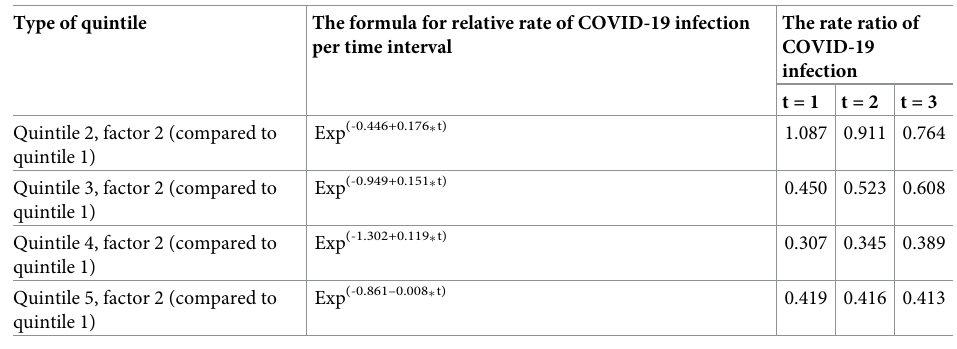
Table 4. COVID-19 incidence rate